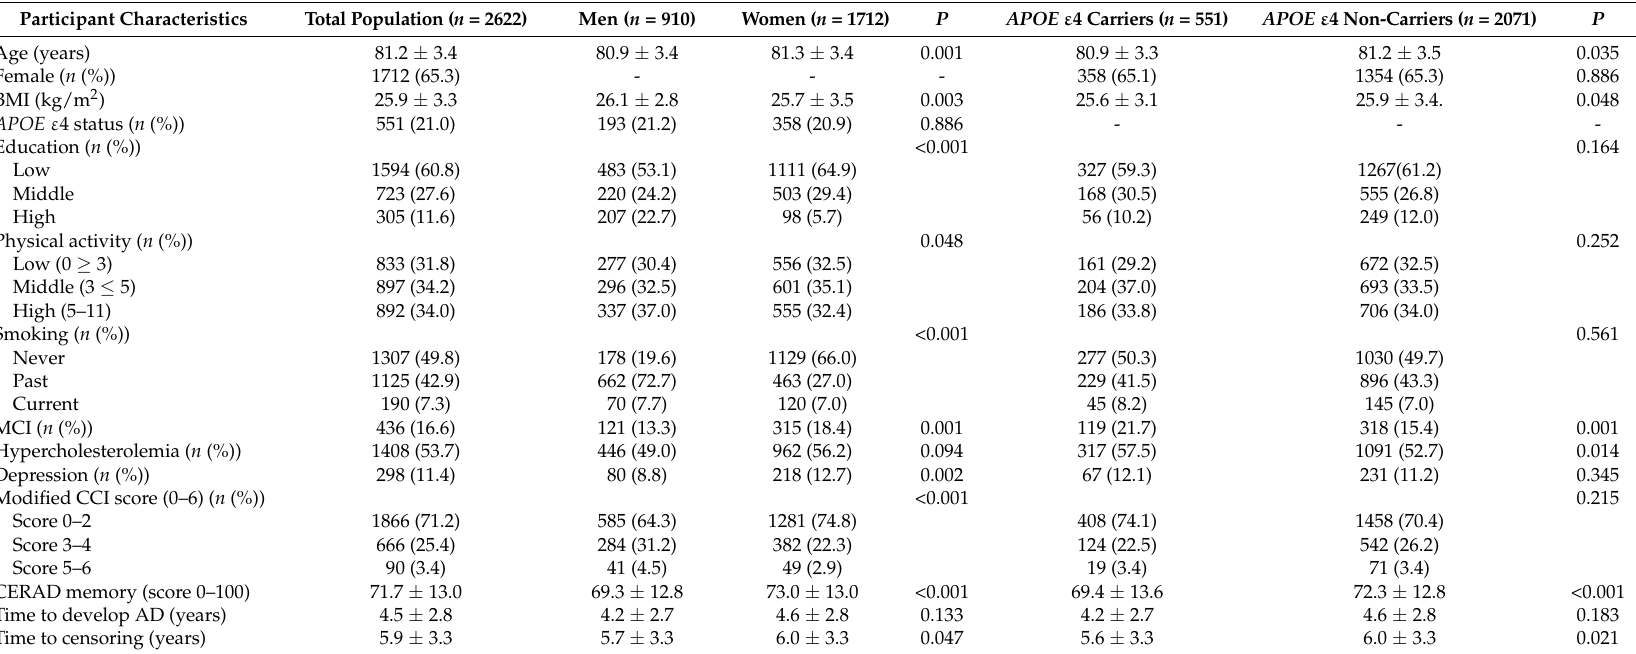
Table 1. Participant characteristics of the AgeCoDe cohort at follow-up